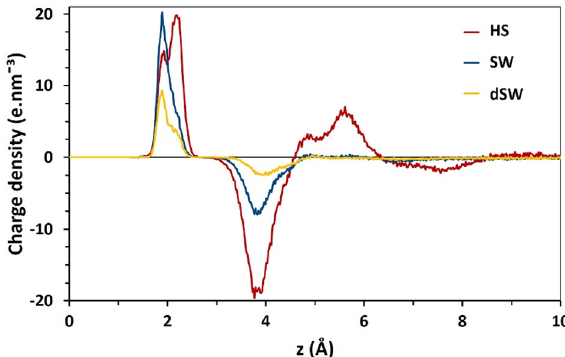
Figure 5. Charge density profile of ions over calcite surface at different brine